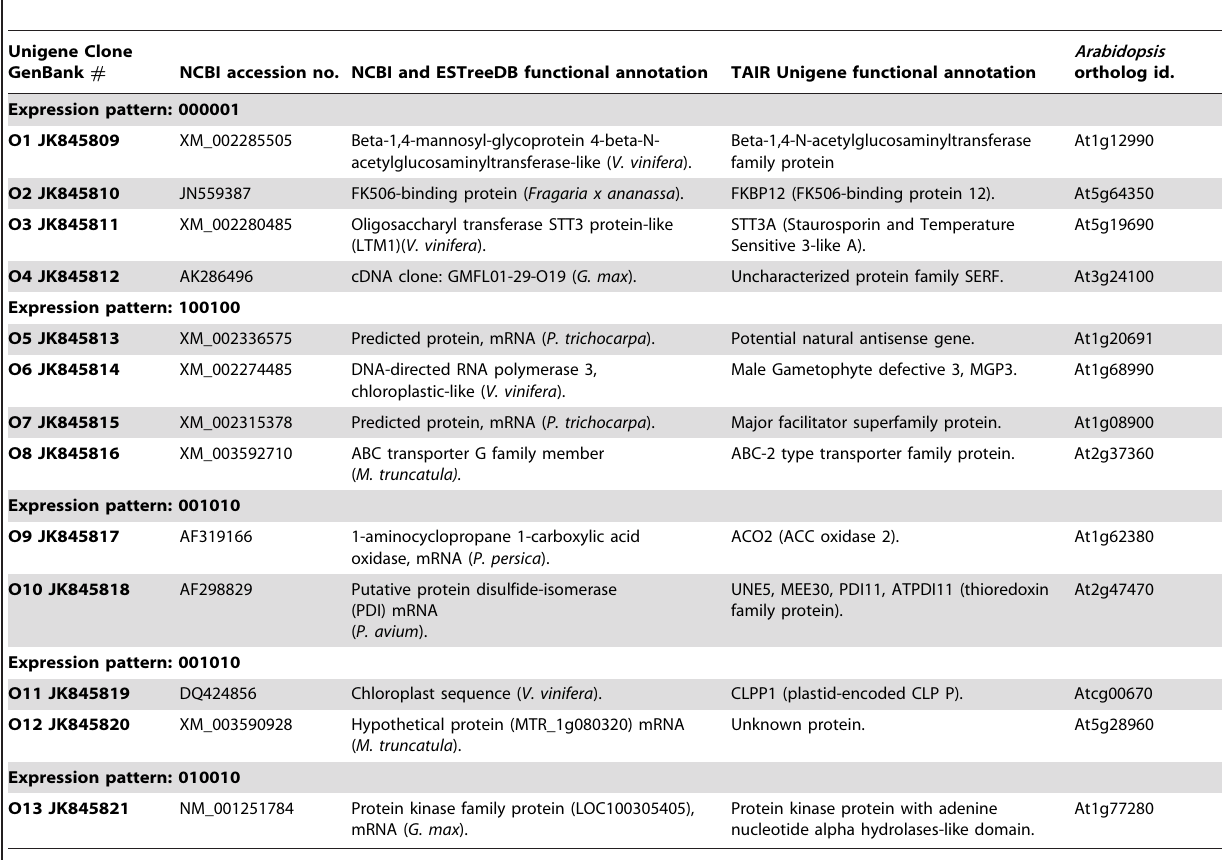
Table 4. Functional identity and gene ontology description of the isolated unigenes corresponding to the ‘‘Other Group’’ (OG) unigenes.